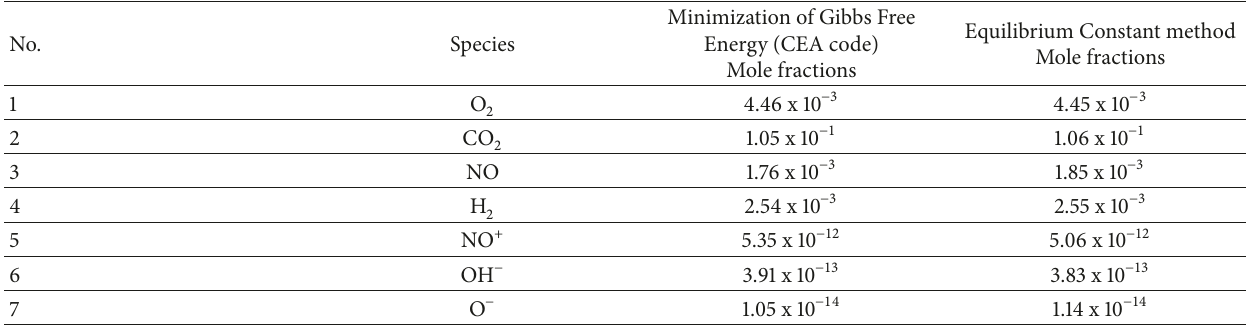
Table 4: Validation of equilibrium constant method with CEA